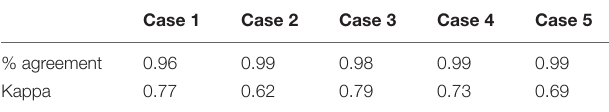
TABLE 1 | Inter-rater reliability values across